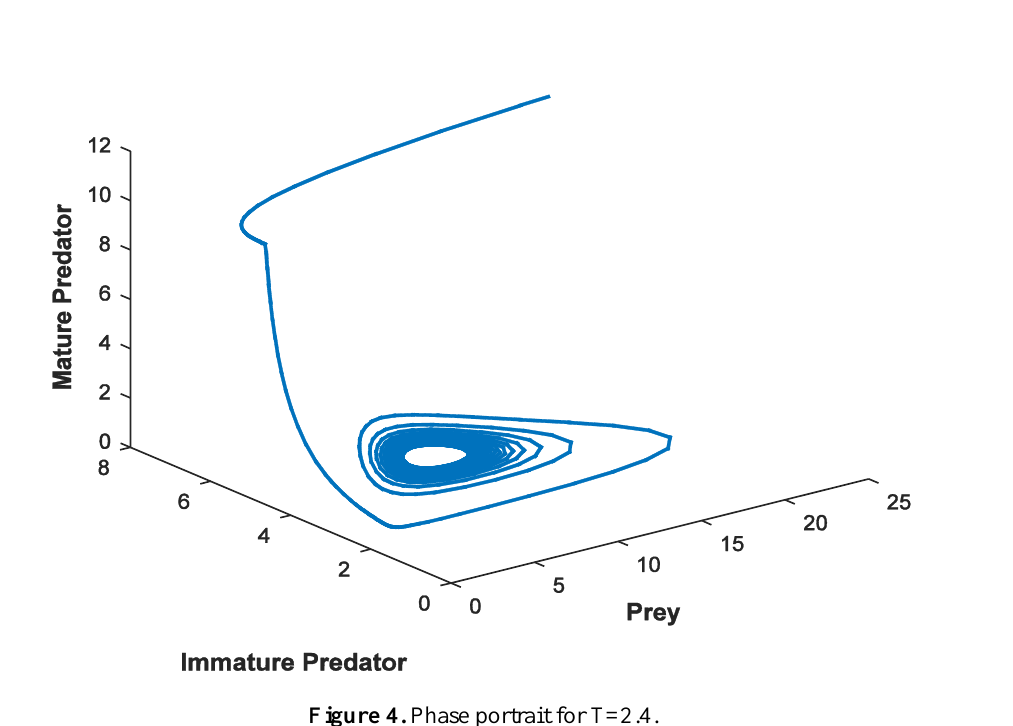
Figure 4. Phase portrait for T=2.4.